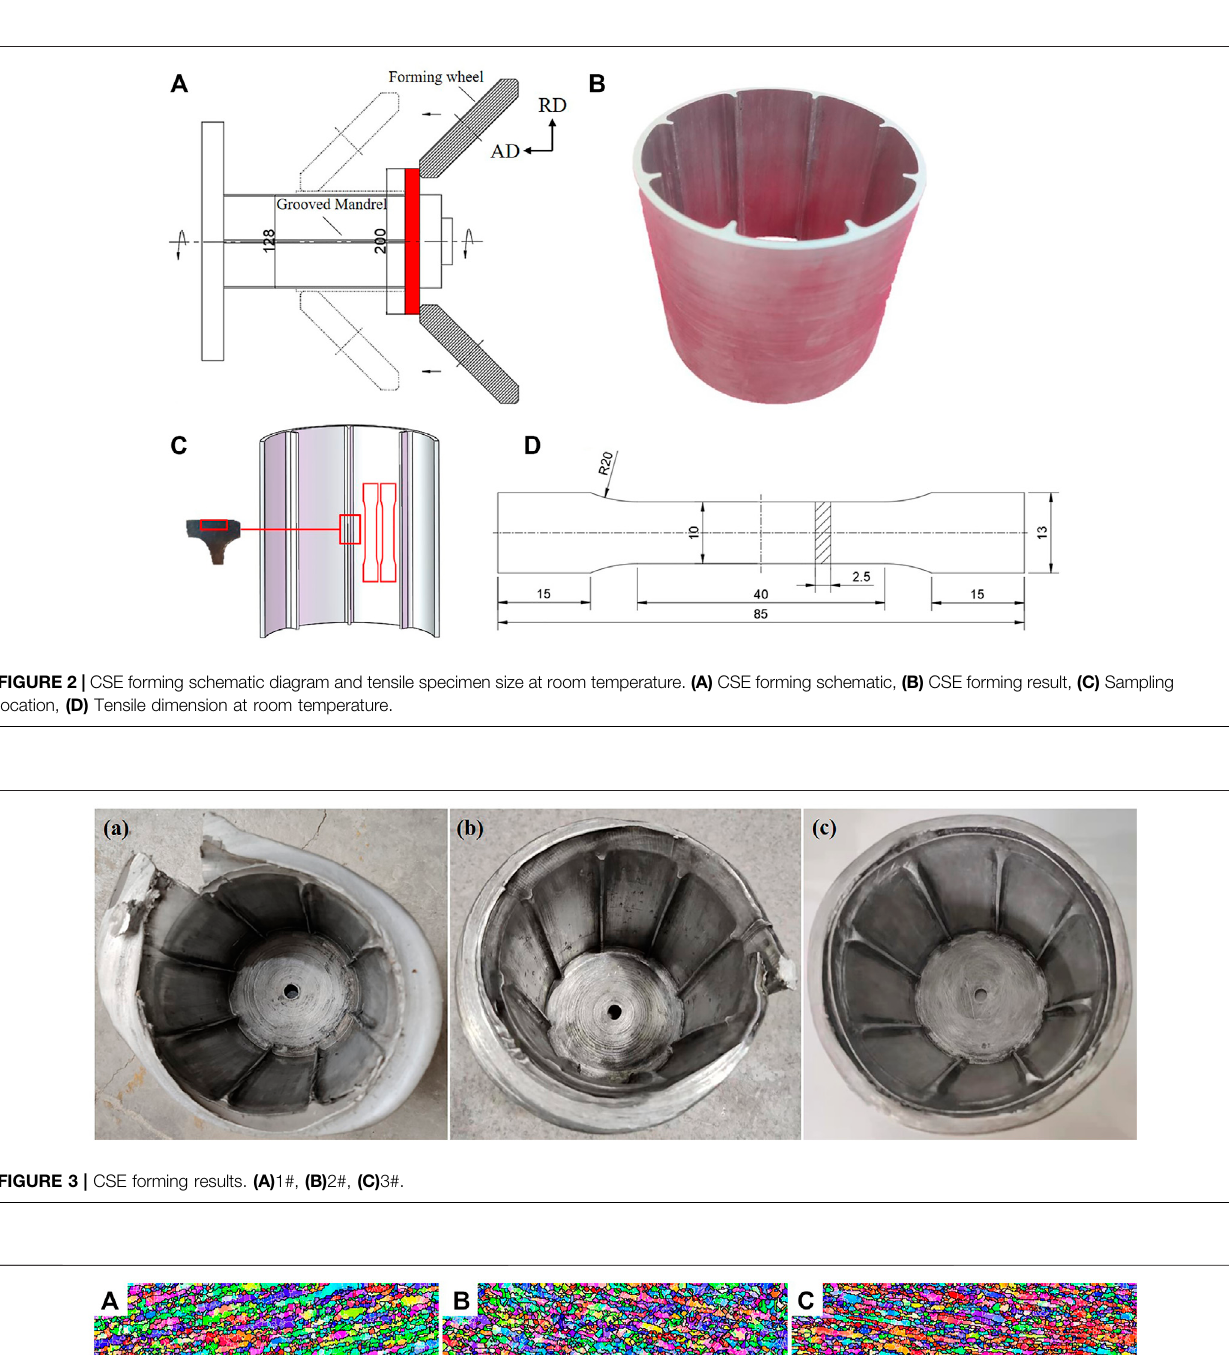
Frontiers in Materials |